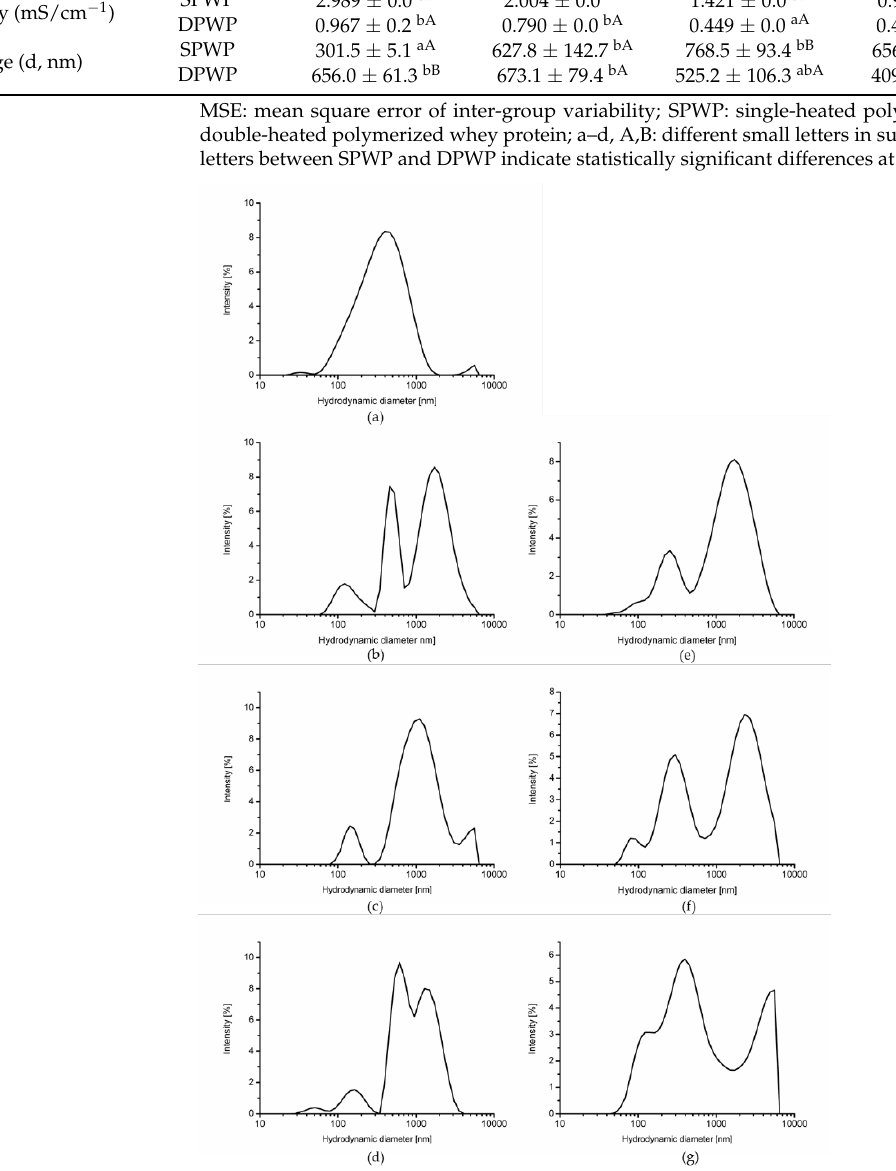
Figure 1. Particle size of polymerized whey protein depending on heating time ( a ): 0 min of heat treatment; ( b – d ): single-heated polymerized whey protein after 10, 20, and 30 min of heat treatment, respectively.; ( e – g ): double-heated polymerized whey protein after 10, 20, and 30 min of heat treatment, respectively.